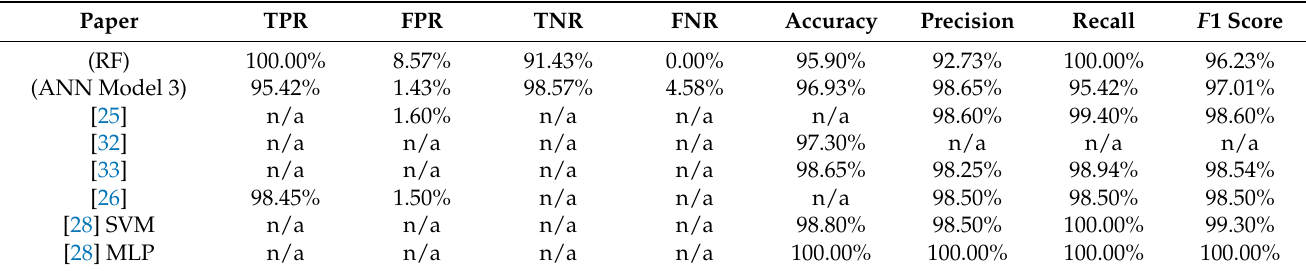
Table 4. Comparison with results from previous